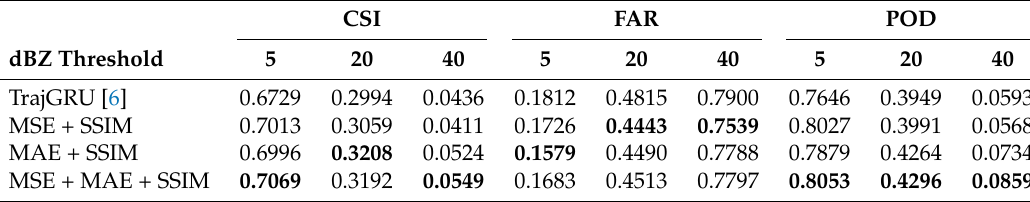
Figure 8. Example of predicted results of the dec-TrajGRU model trained with different loss functions. The result of dec-TrajGRU from Section 4.2 is copied here for convenient comparing. Table 4. Comparison of our three best models with TrajGRU [6] implemented in Section 4.1 over CSI, FAR and POD (average score of the whole sequence). CSI and POD are expected to increase while FAR is expected to